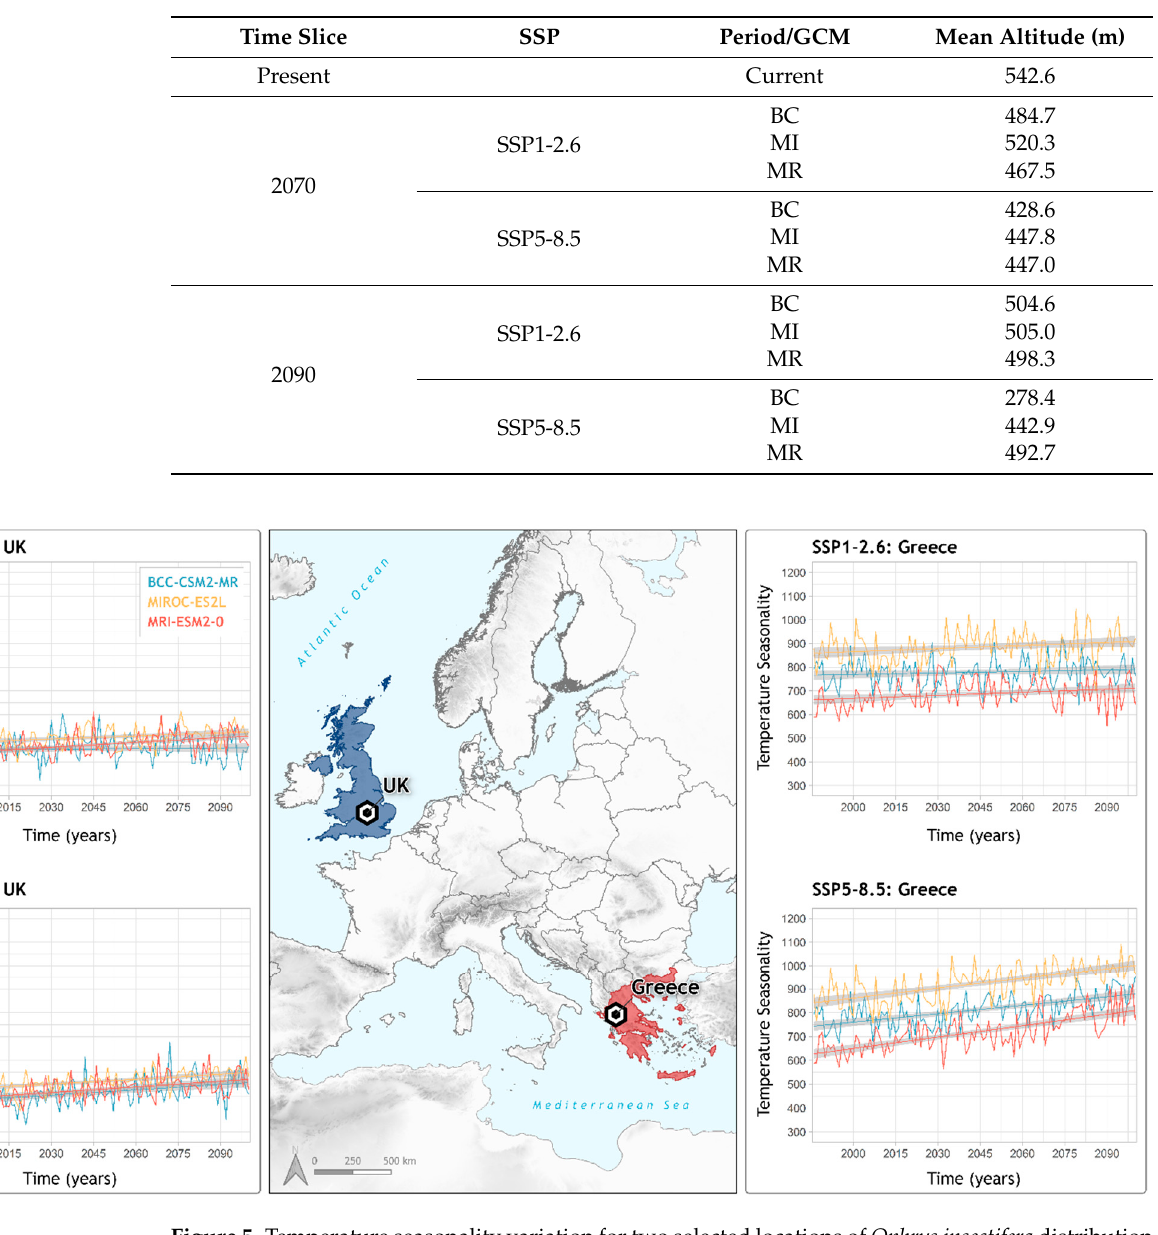
Table 2. Mean altitude for present and future projections of Ophrys insectifera distribution. For the future, two time slices, 2070 (2061–2080) and 2090 (2081–2100), are presented for all selected global circulation models (GCMs) and two shared socioeconomic pathways (SSPs), representing ‘best’- and ‘worst’-case scenarios respectively. BC: BCC-CSM2-MR, MI: MIROC-ES2L, MR: MRI-ESM2-0. SSP1-